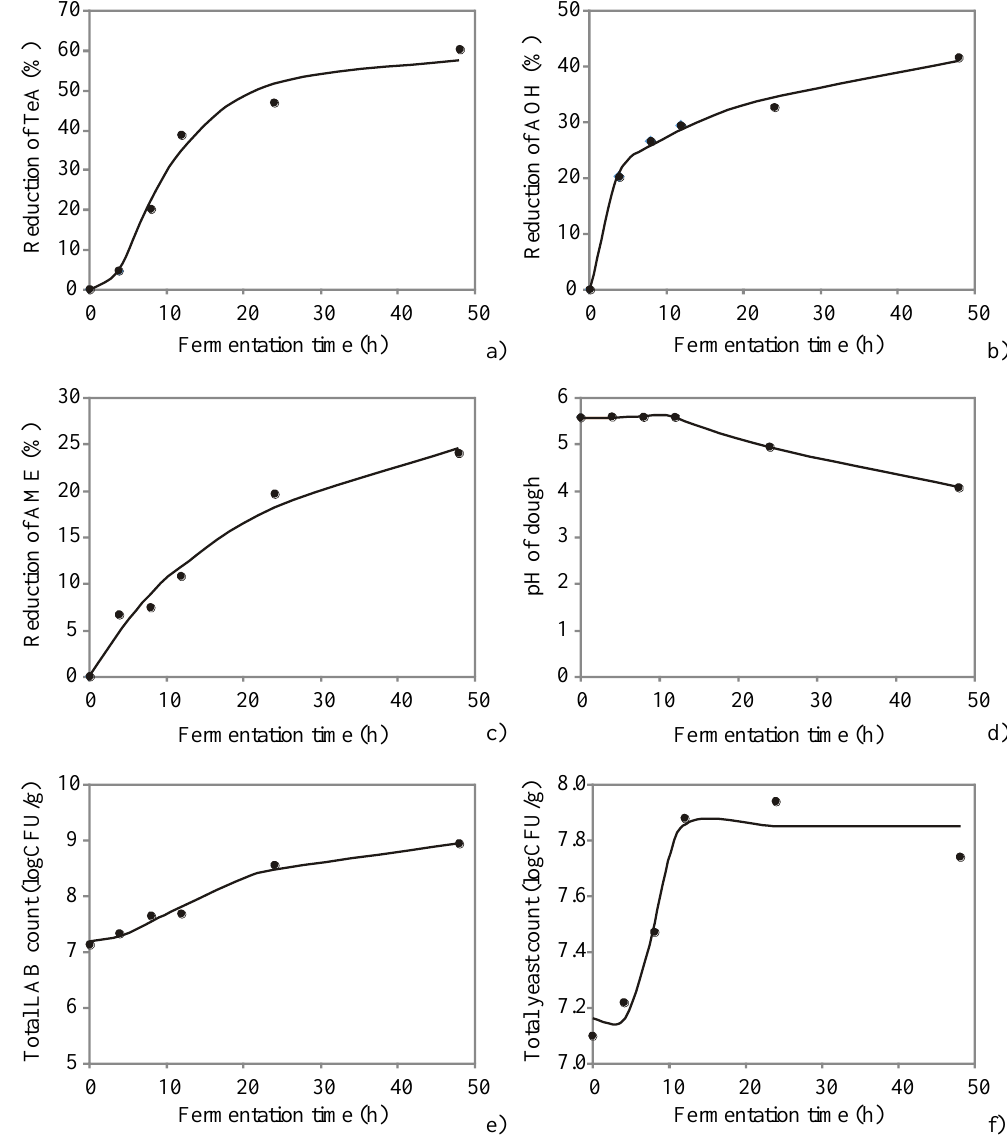
Figure 1. Resulting plots for the model of the leavening process of doughs: ( a ) reduction of tenuazonic acid (TeA), ( b ) reduction of alternariol (AOH), ( c ) reduction of alternariol monomethyl ether (AME), ( d ) pH of the dough during the process, ( e ) total lactic acid bacteria (LAB) count, ( f ) total yeast count.